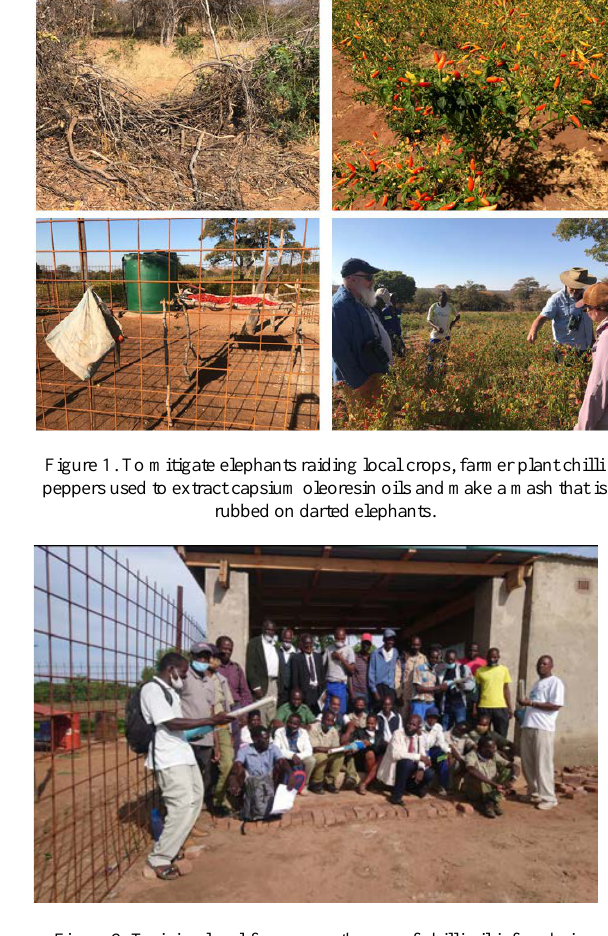
Figure 2 . Training local farmers on the use of chilli oil infused ping pong balls and potato launchers to drive away raiding elephants.